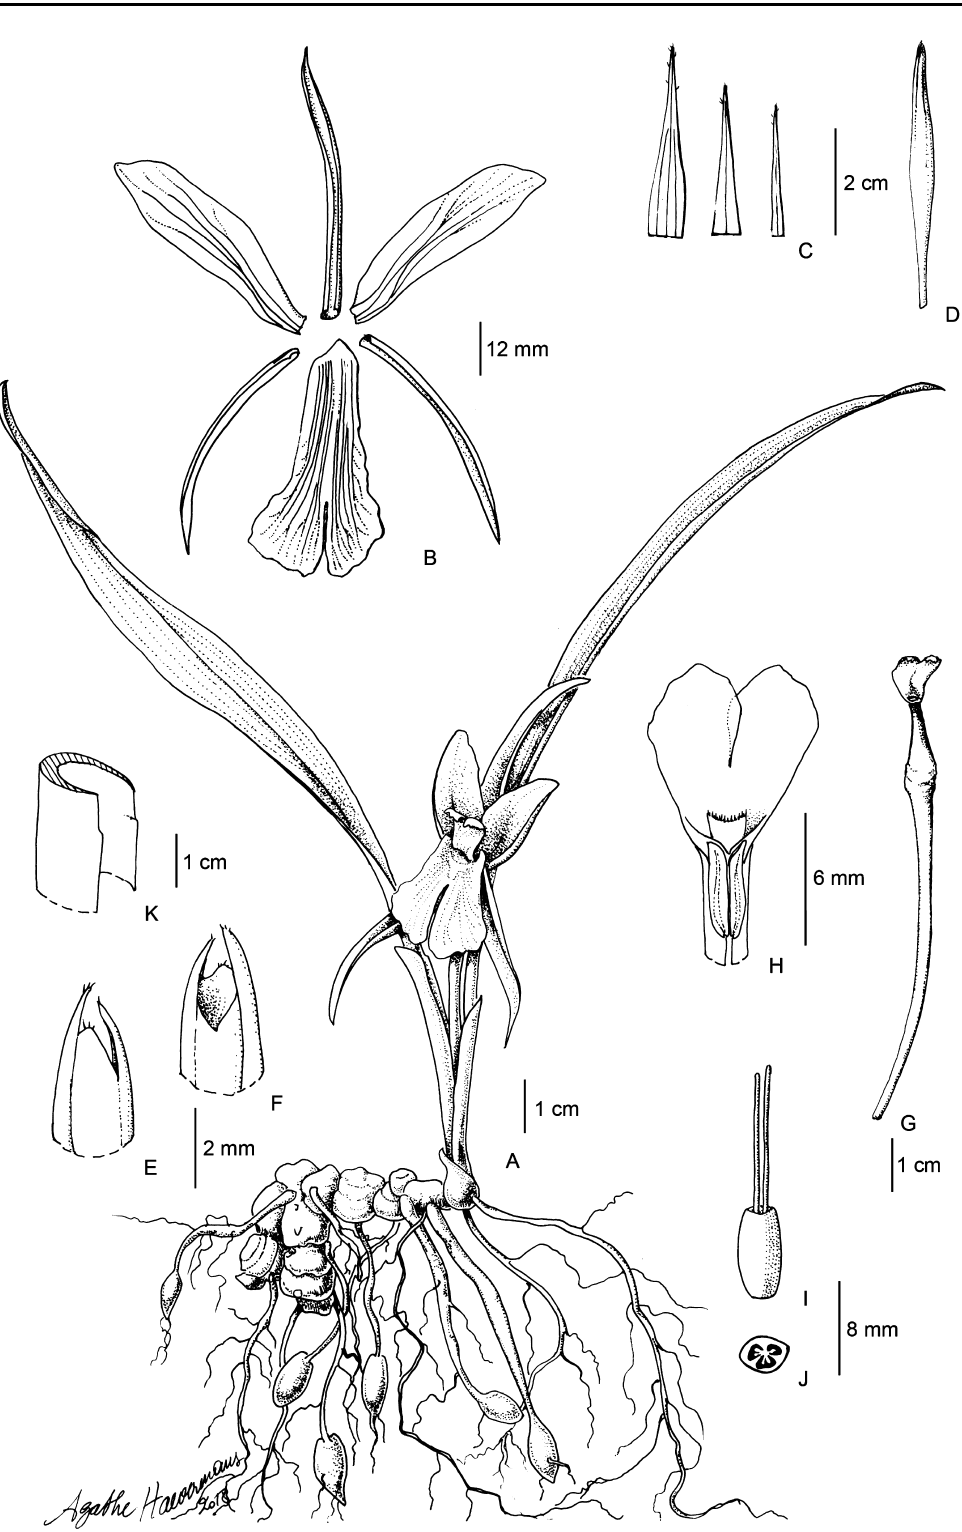
Fig. 2. Kaempferia nemoralis Insis. sp. nov. A . Whole plant. B . Flower dissected. C . Bract and bracteoles. D . Calyx. E . Calyx apex (back view). F . Calyx apex (front view) (dorsal corolla lobe side). G . Floral tube with stamen attached. H . Anther. I . Ovary and epigynous glands. J . Ovary cross section. K . Ligule. Drawing from the type material by Agathe Haevermans ( O. Insisiengmay et al. OI 234